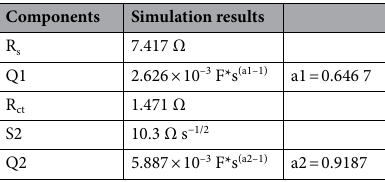
Table 4. Simulation Results from curve fitting from EC-Lab Z-fit software for P12.